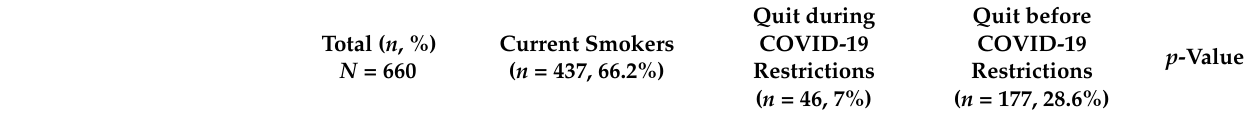
Table 2. COVID-19 risk perceptions by smoking status, chronic disease, and stress levels ( N = 660), Israel, 2020. Quit before Quit during COVID-19 COVID-19 Total ( n , %) Current Smokers p -Value N = 660 Restrictions Restrictions ( n = 437, 66.2%) ( n = 177, 28.6%) ( n = 46, 7%) Perception of smokers’ risk for Sars-CoV-2 infection (missing n = 1) Higher risk 316 (48%) 205 (47%) 25 (54.3%) 86 (48.6%) 0.627 Same or lower risk 343 (52%) 231